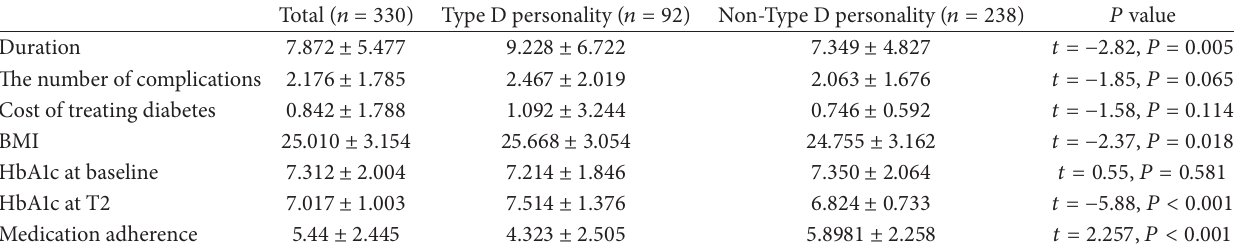
Table 2: The comparison of the clinical outcomes between the patients with or without Type D